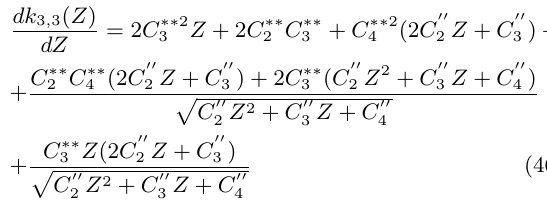
Figure 28: Links and joints of the existing Gantry-Tau